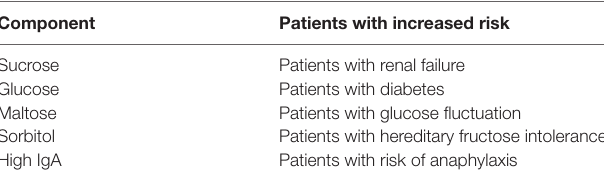
TAbLe 1 | Components of immunoglobulin products associated with adverse effects.